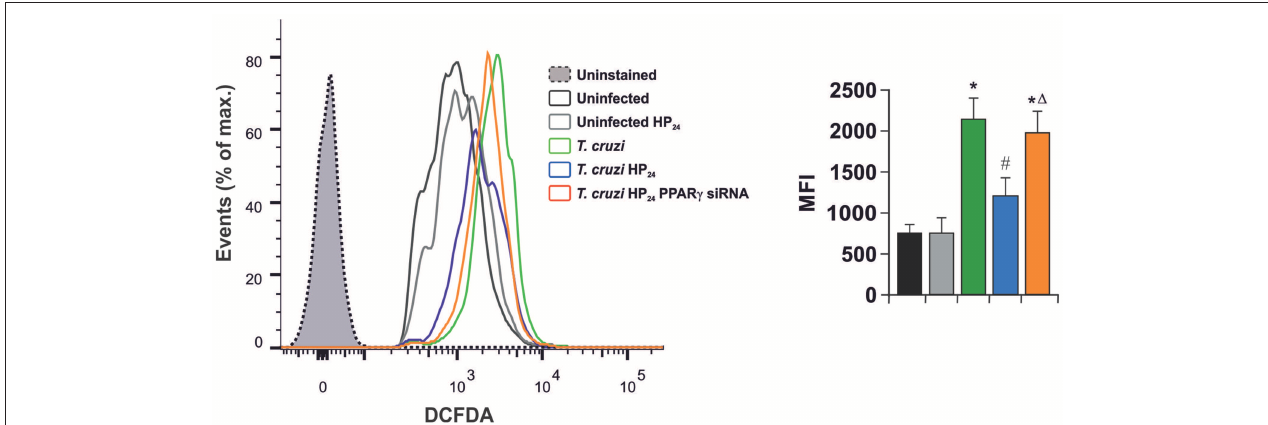
FIGURE 6 | HP 24 inhibits H 2 O 2 production through PPAR γ in T. cruzi -infected macrophages. Peritoneal macrophages were obtained and transfected with PPAR γ -siRNA for 72h. Transfected or non-transfected cells were treated with HP 24 (100 µ M) since 30min before infection. Then, these cells were infected with T. cruzi for 24h (parasite:cell ratio 5:1). Sample histogram shows H 2 O 2 generation measured by flow cytometry using 2 ′ ,7 ′ dichlorofluorescein-diacetate (DCFDA). Ten thousand events were acquired for each group. Data are presented as the mean MFI ± SEM of three independent experiments. * P < 0.05 vs. uninfected cells, # P <